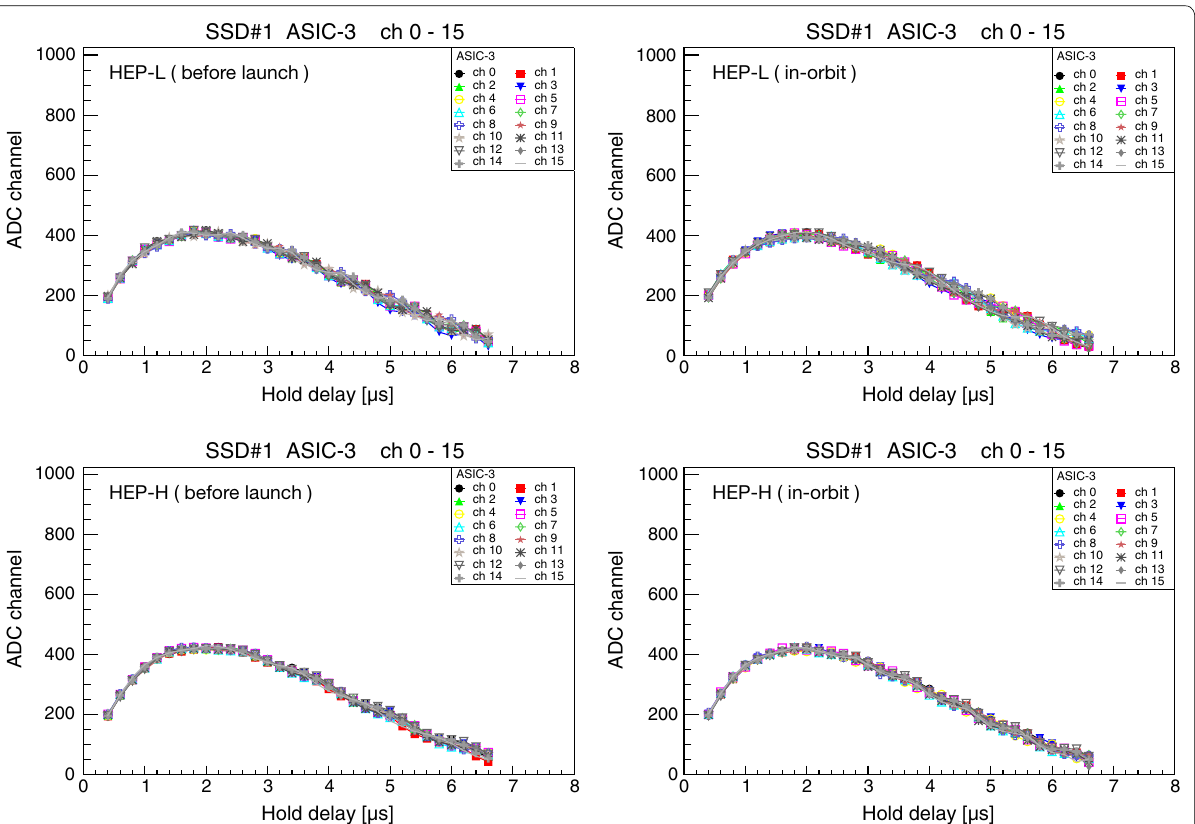
Fig. 12 Waveforms of shaping amplifier output measured while in orbit (right) compared to preflight measurements (left) for performance